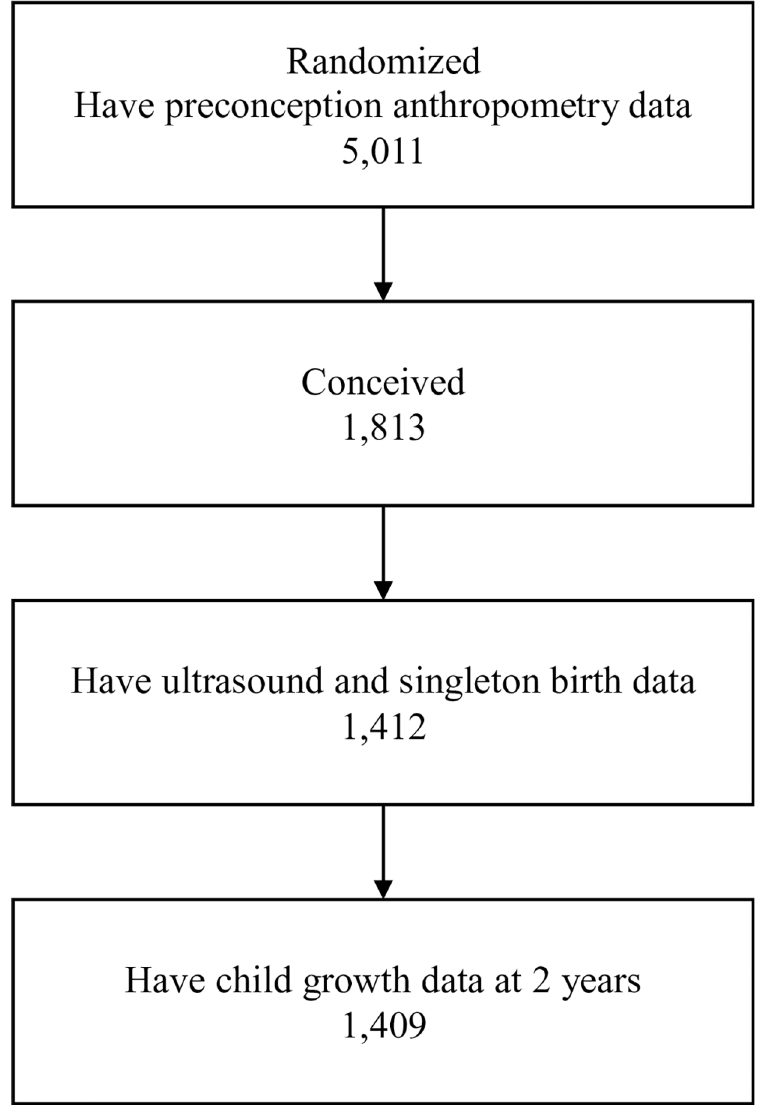
Fig 1. Flow diagram of participant progress throughout the study. Flow diagram of participant enrollment and follow-up of mother-child pairs. and Small for gestational age (SGA). Gestational age was based on the date of last menstrual